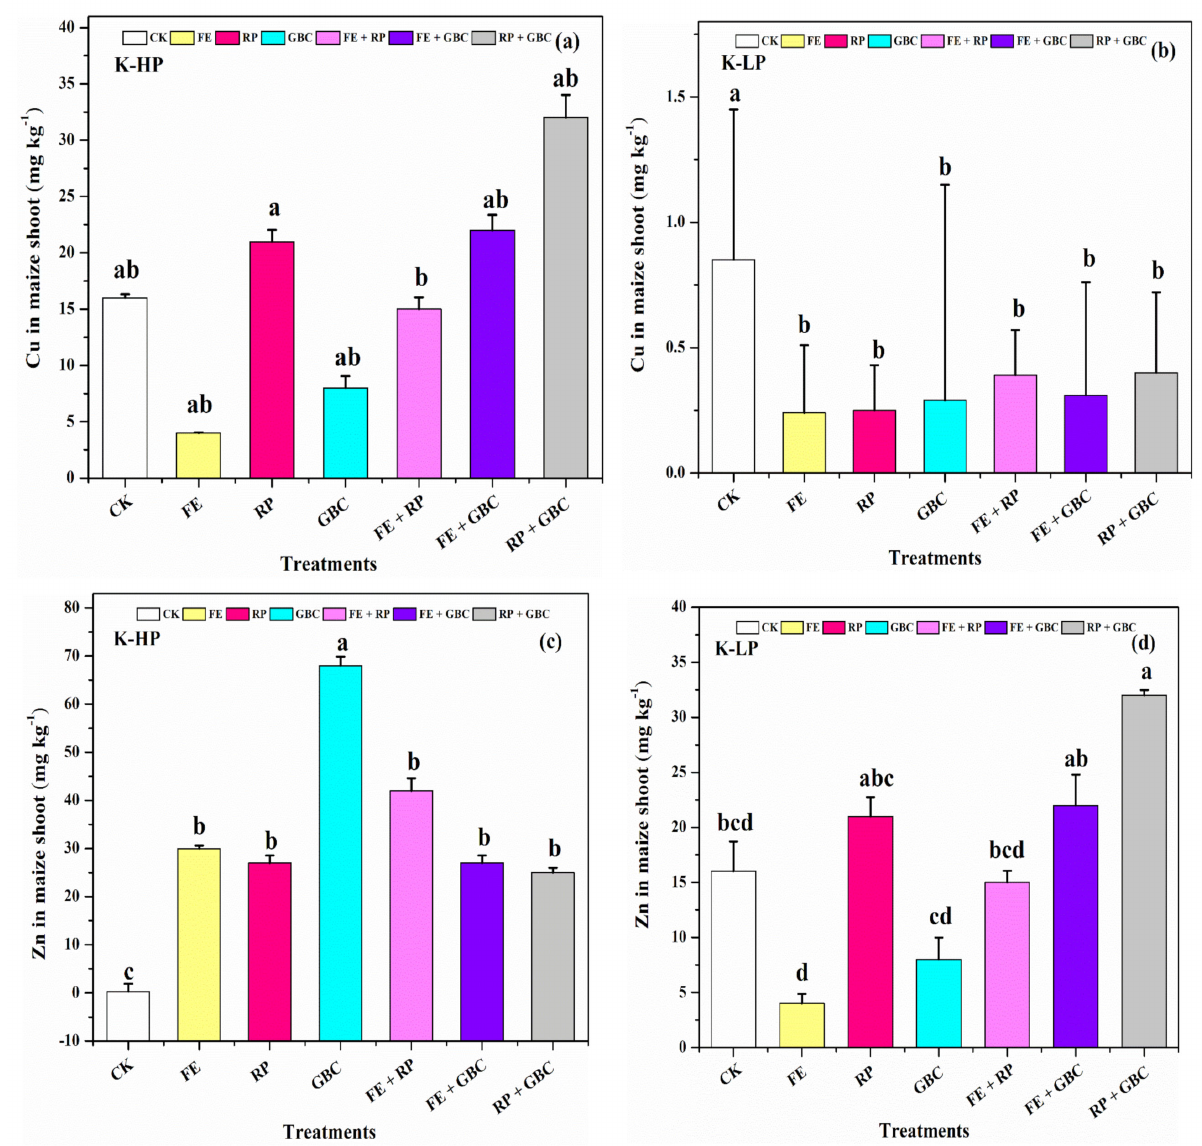
Figure 7. Influence of additives on Cu in ( a ) K-HP maize shoot and ( b ) K-LP maize shoot; influence of additives on Zn in ( c ) K-HP maize shoot and ( d ) in H-LP maize shoot. The values in a given column followed by the same letter are statistically not significantly ( p < 0.05) using Tukey’s HSD